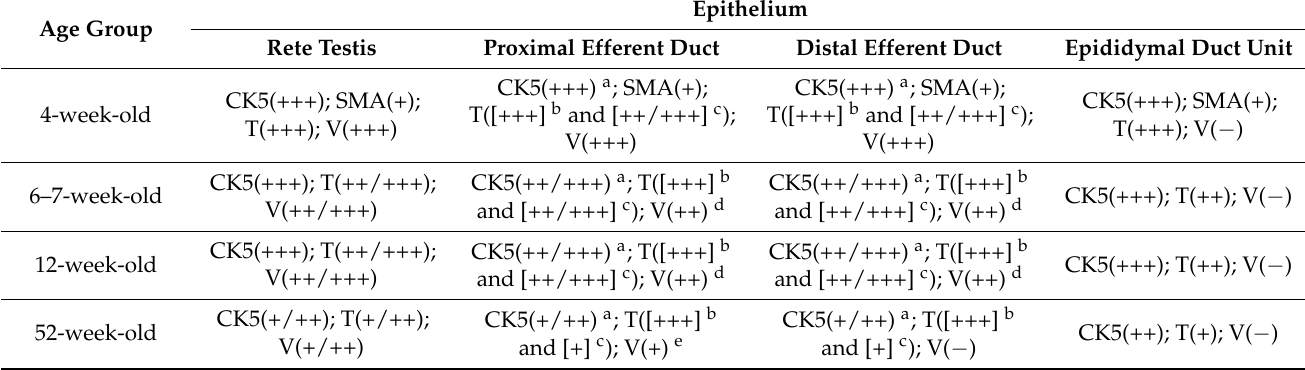
Table 2. Summary of intensities and immunolocalization of cytokeratin 5 (CK5), alpha-smooth